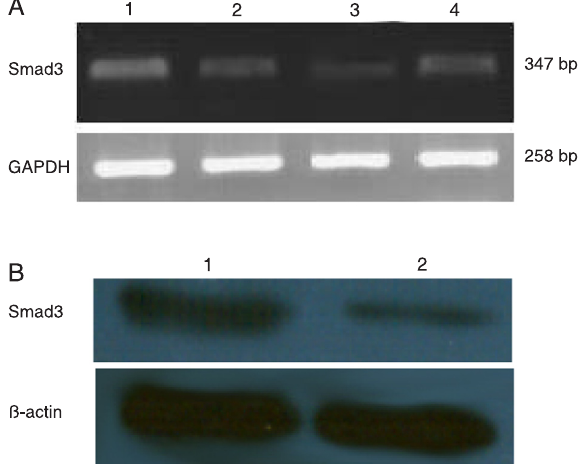
Figure 4. A , Smad3 mRNA expression following transfection with different Smad3 siRNA expression vectors. Lane 1 : Normal HSC- T6; lanes 2-4 : hepatic stellate cells (HSCs) transfected with one of three different Smad3 siRNA expression vectors. B , Western blot of Smad3 protein following transfection with a Smad3 siRNA ex- pression vector. Lane 1 : Normal HSCs; lane 2 : HSCs transfected with the SD1211-SiSmad3-2 siRNA